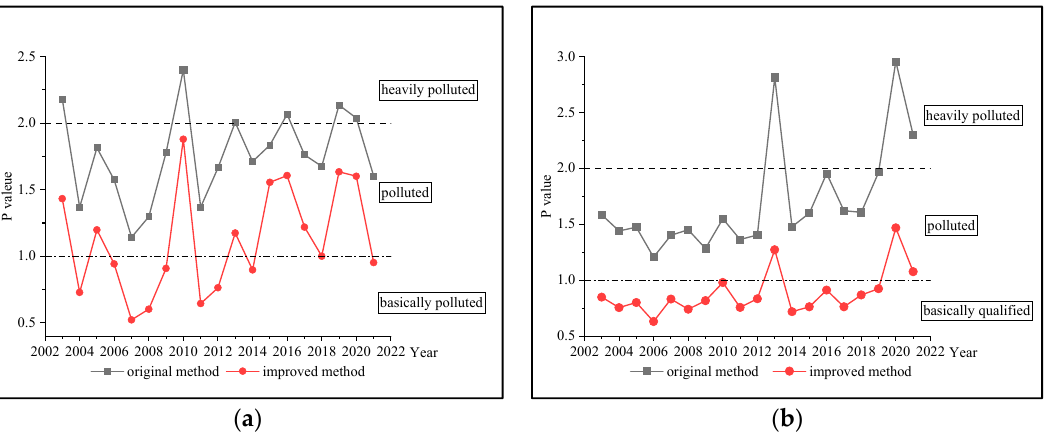
Figure 8. Comprehensive pollution index of the Beizamu section from 2003 to 2021. ( a ) low water period (May), ( b ) high water period (September).